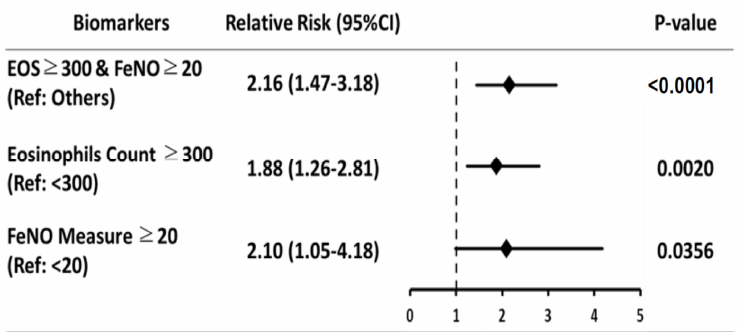
Figure 2. The association between Exacerbation and Biomarkers.